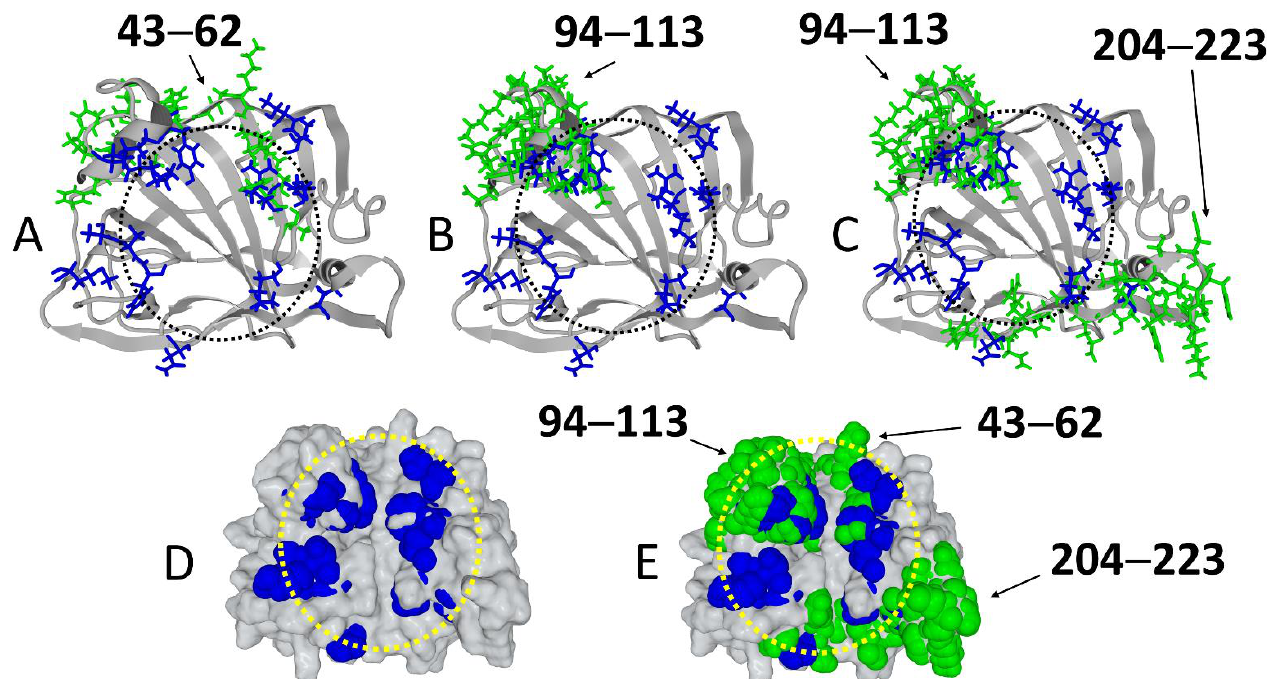
Figure 3. Predicted B epitopes overlap the annular ganglioside-binding motif of the E8L protein. The amino acid residues that constitute the three potential B epitopes are colored in green. These epitopes lie within the 43–62 ( A ), 94–113 ( B ) and 204–223 ( C ) segments of the E8L amino acid sequence. Note that the 94–113 and 204–223 are separate epitopes ( C ) whereas 43–62 and 94–113 significantly overlap ( A , B ). In the unbound E8L protein, some amino acid residues belonging to the ganglioside-binding domain (blue spheres) are not immediately accessible on the protein surface ( D ). However, the three epitopes (represented in green atomic spheres) are fully accessible ( E ). The dashed circles underscore the annular organization of the ganglioside-binding motif.